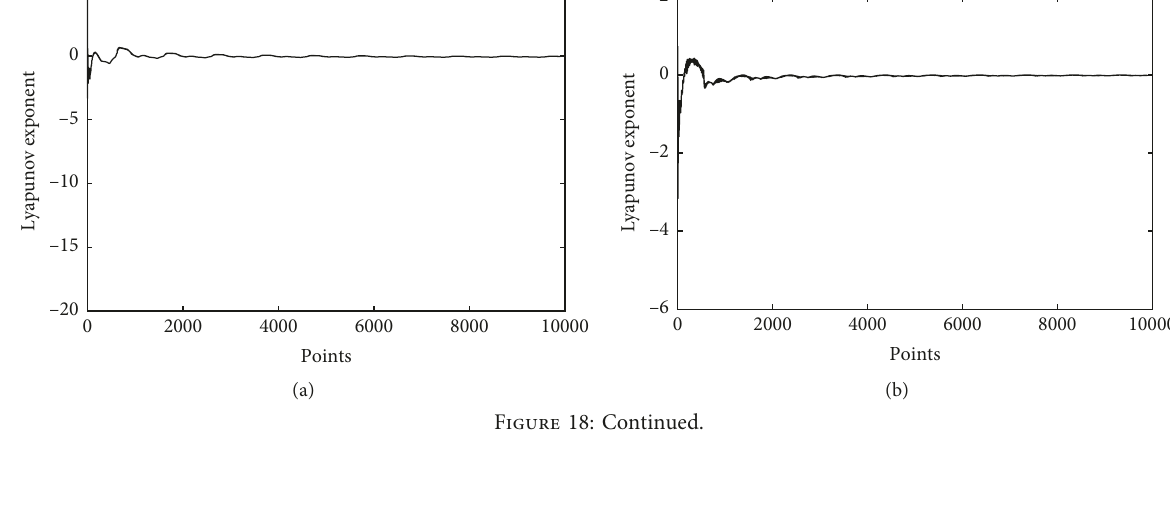
� − π ( rad / s ) , ω 1 � 2 . 5 π ( rad / s ) . 4